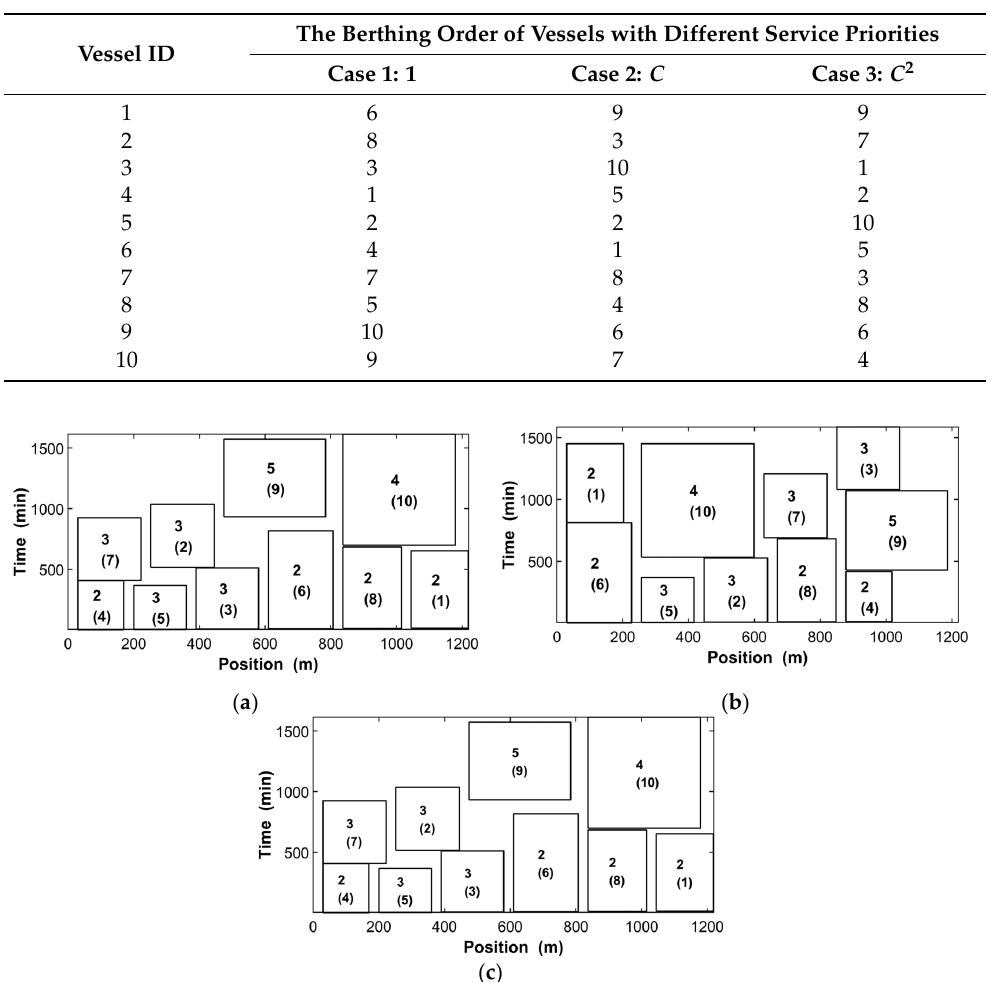
Figure 5. Time-location diagrams under different service priorities. ( a ) w (cid:8) (cid:9) C 2 ( c ) w i =